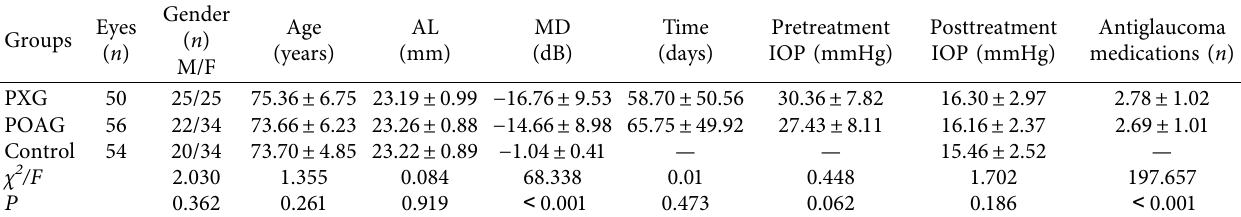
PXG: pseudoexfoliative glaucoma; POAG: primary open-angle glaucoma; M: male; F: female; IOP: intraocular pressure; AL: axial length; MD: mean defect; Time: duration between the first diagnosis and study